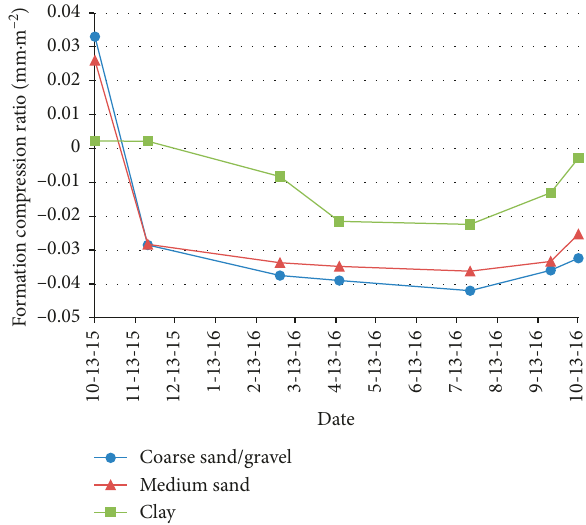
Figure 10: Compression rate of strata near the west ventilation shaft in the Xinglongzhuang Coal